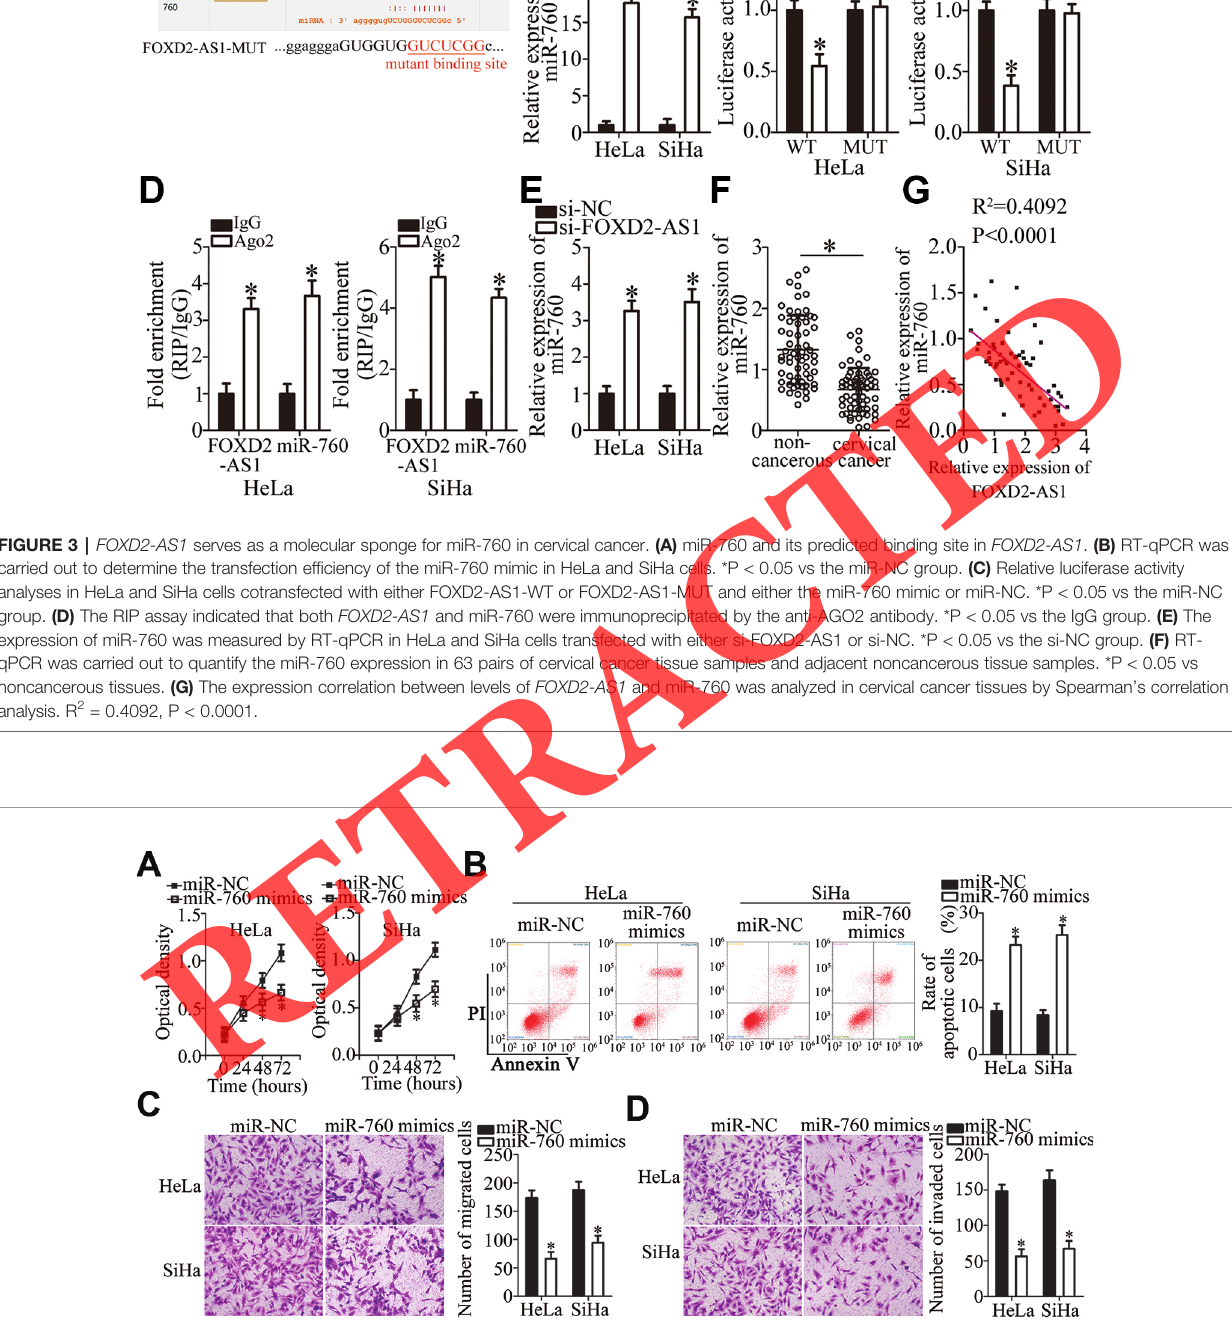
FIGURE 4 | miR-760 exerts an inhibitory effect on the growth and metastasis of cervical cancer cells in vitro . (A, B) The proliferation and apoptosis of miR-760 mimic – transfected or miR-NC – transfected HeLa and SiHa cells was evaluated by the MTT assay and fl ow-cytometric analysis. *P < 0.05 vs the miR-NC group. (C, D) Migration and invasion assays were conducted to determine the migratory and invasive abilities of HeLa and SiHa cells overexpressing miR-760. *P < 0.05 vs the miR-NC group.